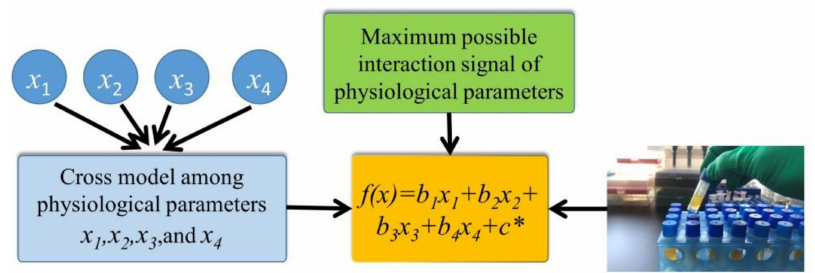
Figure 5. The MLR model used for prediction.